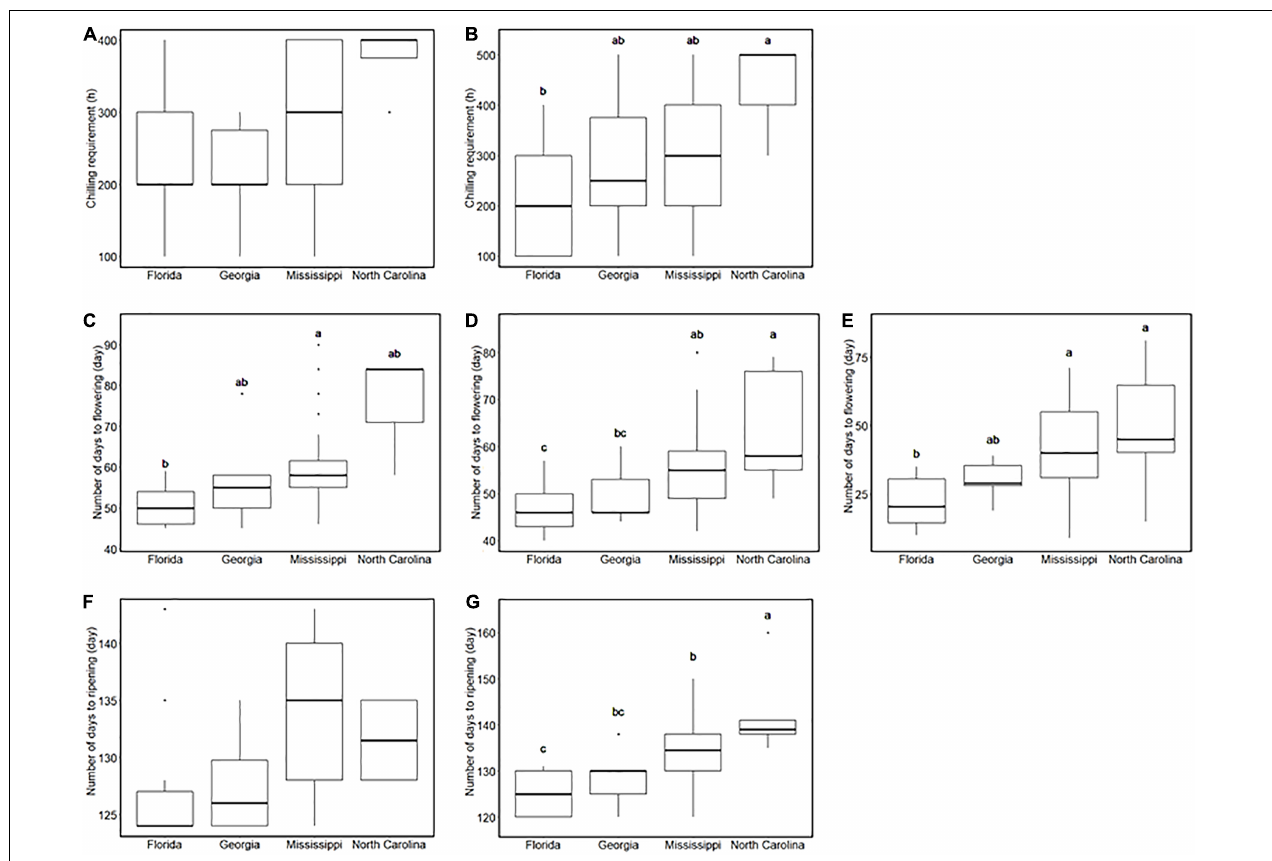
FIGURE 2 | Comparison of phenology-related traits between breeding locations. (A,B) Chilling requirement of southern highbush blueberries (SHBs) in (A) the 2018–2019 season and (B) the 2019–2020 season for each breeding location. (C–E) Flowering date of SHBs in (C) 2018, (D) 2019, and (E) 2020 seasons for each breeding location. (F,G) Ripening date of SHBs in (F) 2018 and (G) 2019 seasons for each breeding location. Different letters represent significant differences ( p <